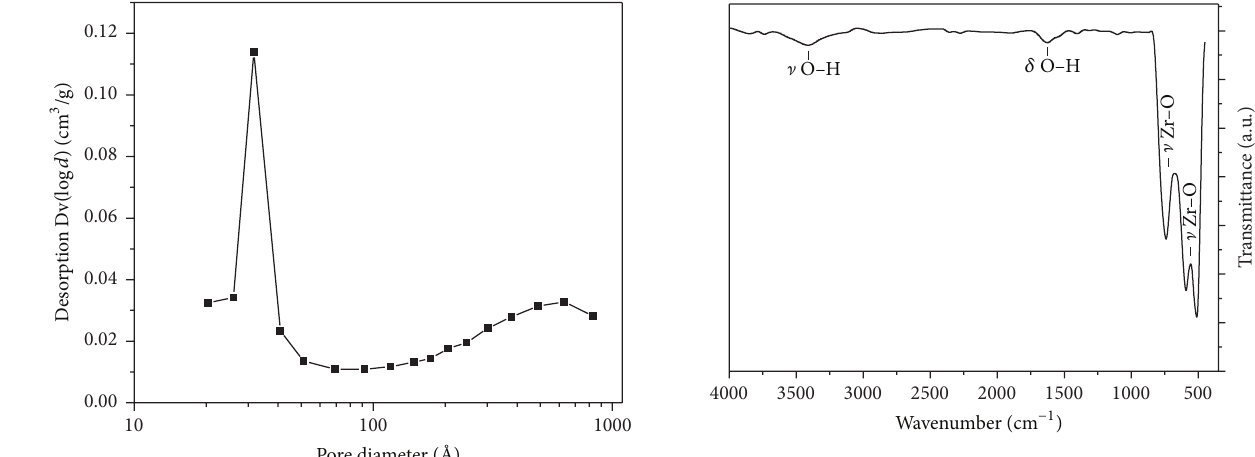
Figure 12: FT-IR spectrum of ZrO 2 sample.